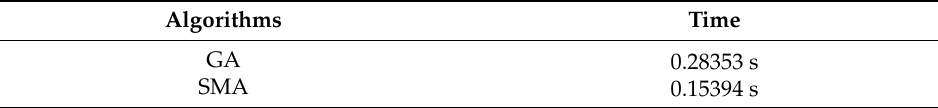
Table 1. Algorithm runtime.